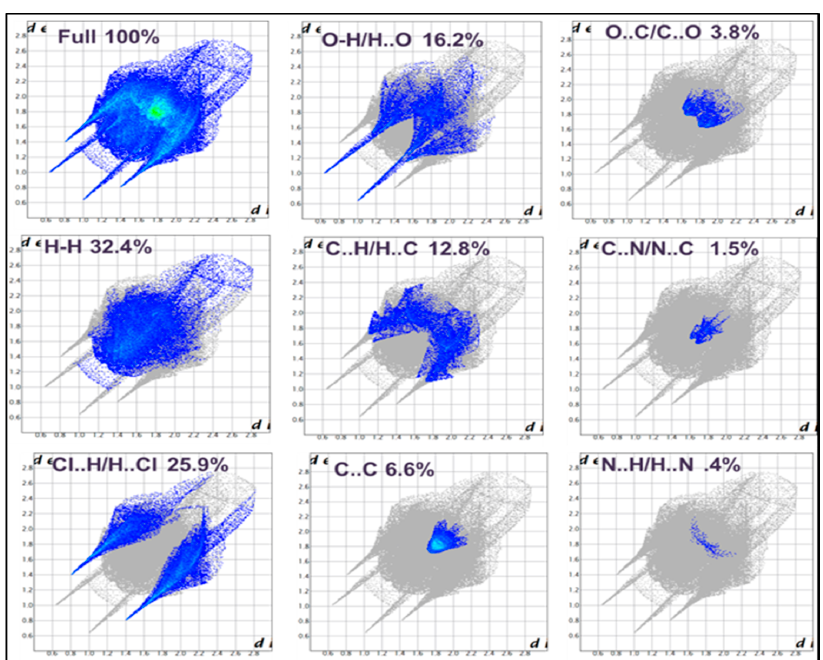
Figure 8. 2D fingerprint plots of complex 1.